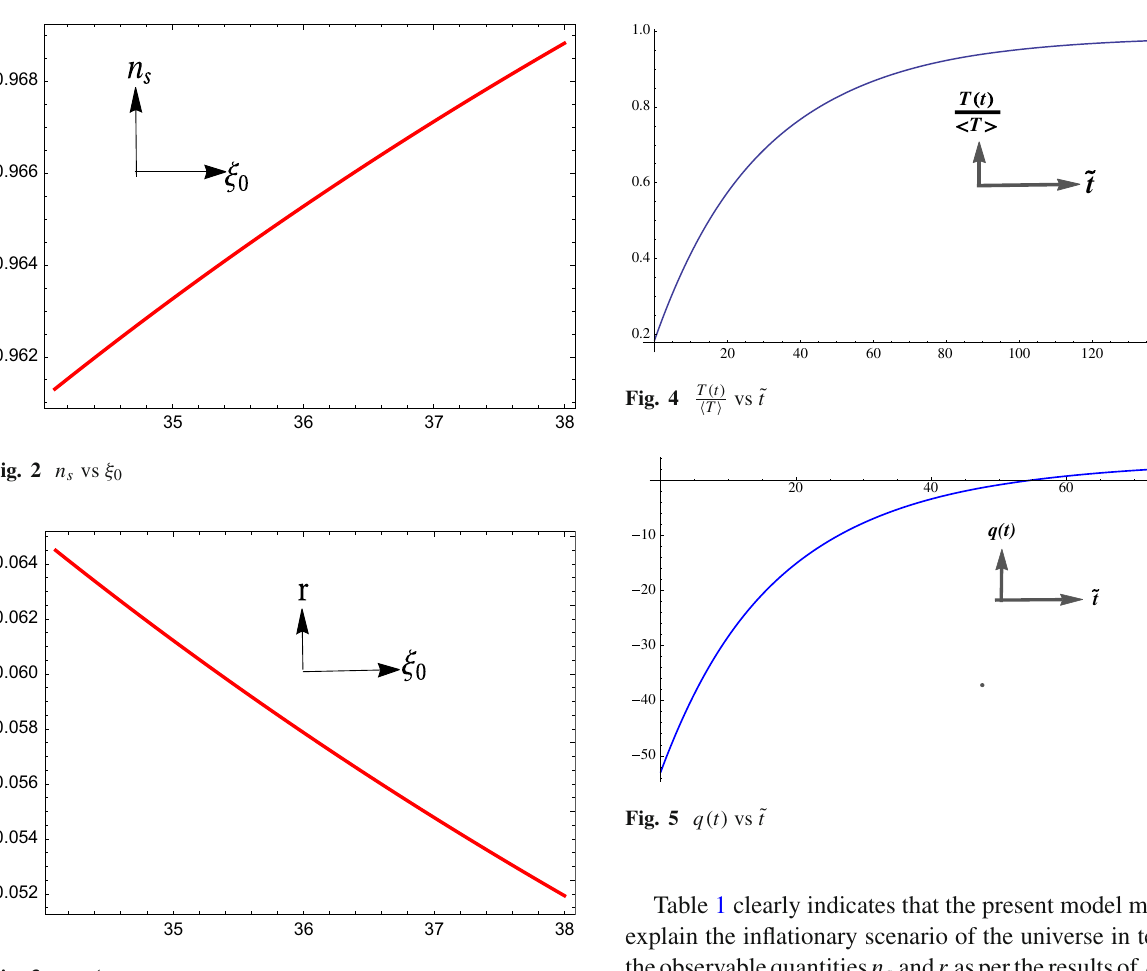
Fig. 3 r vs ξ 0 Table 1 Estimated values of various quantities for κv v = and ξ 0 = 36 Parameters Estimated values